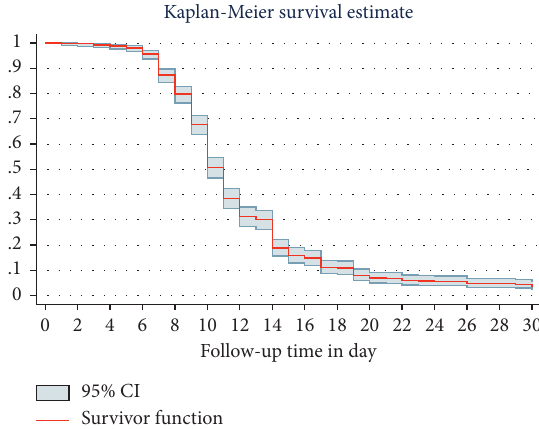
Figure 2: Overall Kaplan–Meier survival curve with 95% confi- dence interval